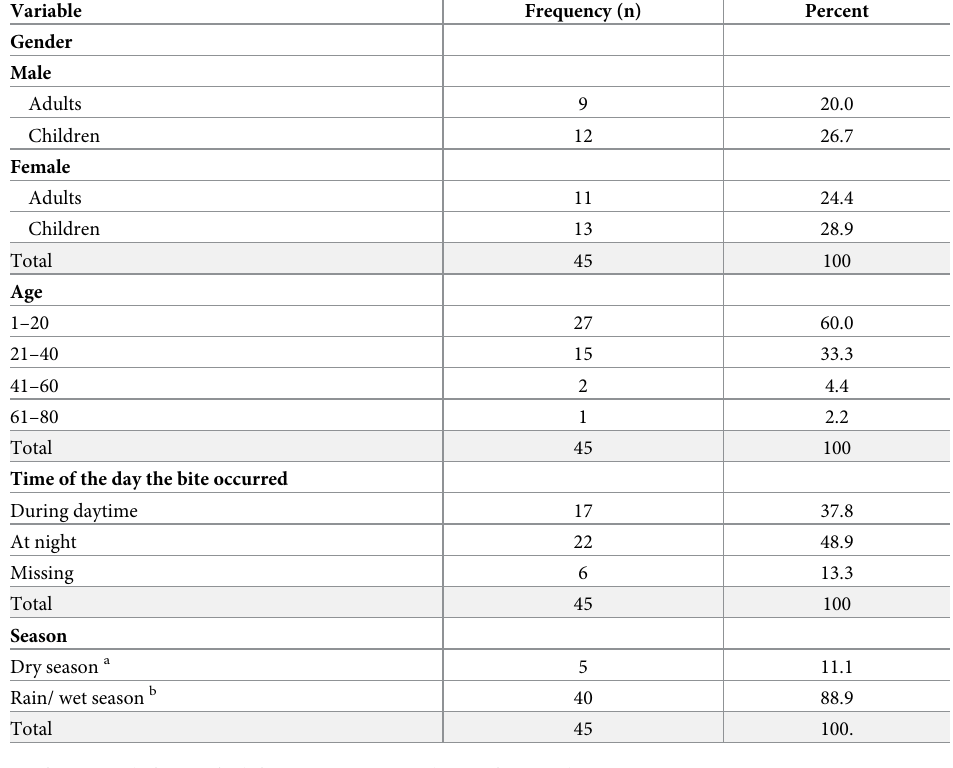
Table 4. The distribution of the characteristics of snakebite patients recorded at Meserani snake park clinic between January 2017 and December 2017 (N = 45).